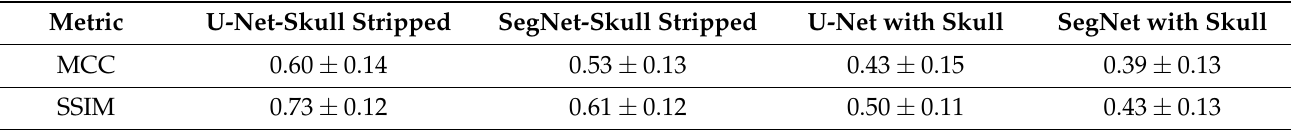
Table 1. The results of the different experiments that have been performed for the MCC and SSIM scores comparing the original images with the corresponding reconstructed